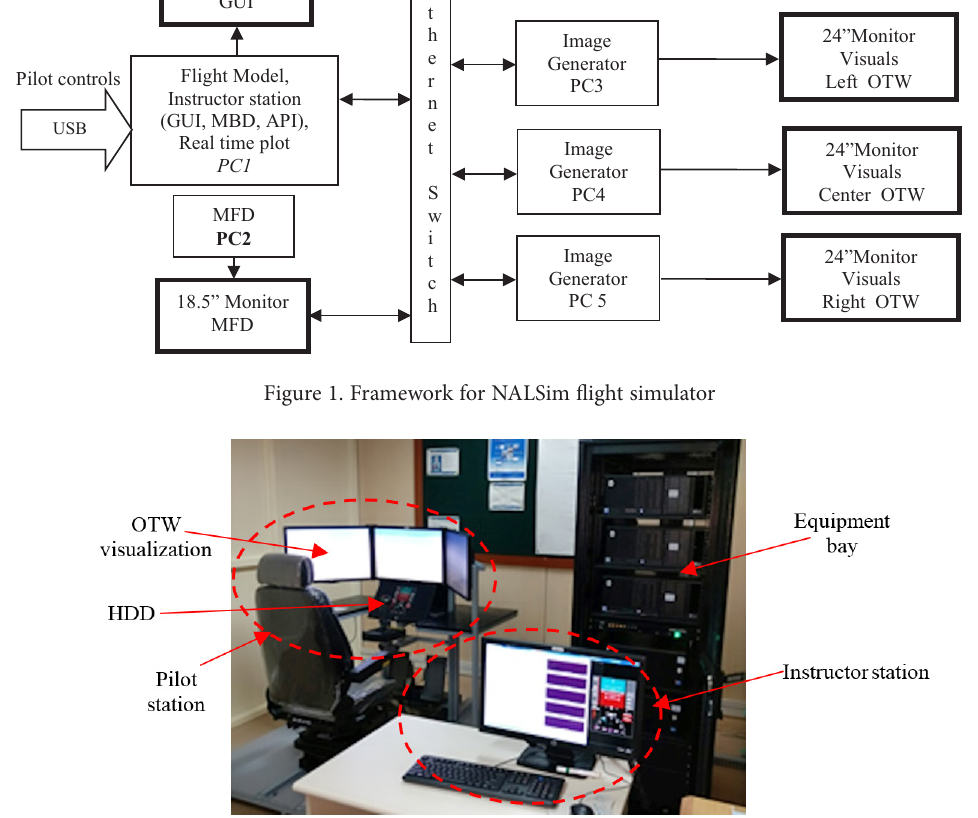
Figure 2. Snapshot shot of NALSim variable stability